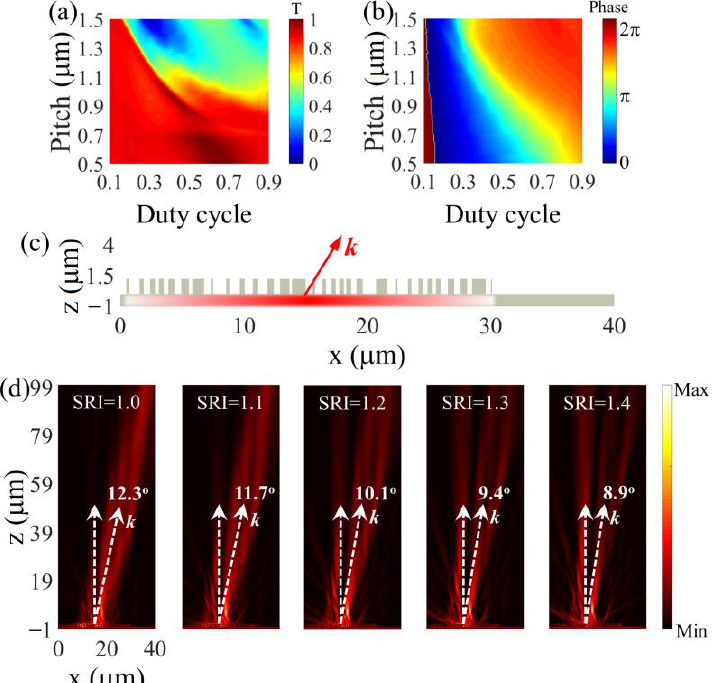
Figure 7. Dependences of ( a ) transmittance and ( b ) phase delay of LN nanopillar on lattice pitch and duty cycle, respectively. ( c ) Schematic and ( d ) SRI-tuned deflection behaviors of the finite non-periodic monolithic metasurface deflector.